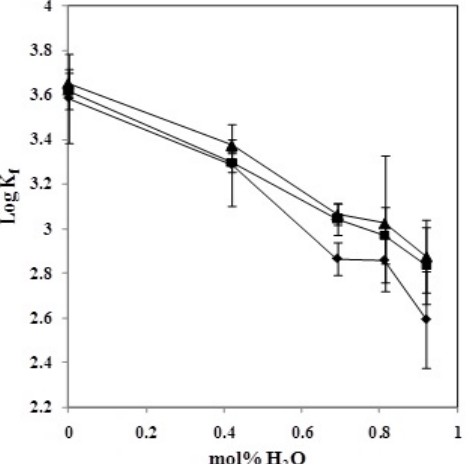
Figure 4. Variation of the stability constant (log K with the composition of AN–H ■ 25 °C, ▲ 35 °C).